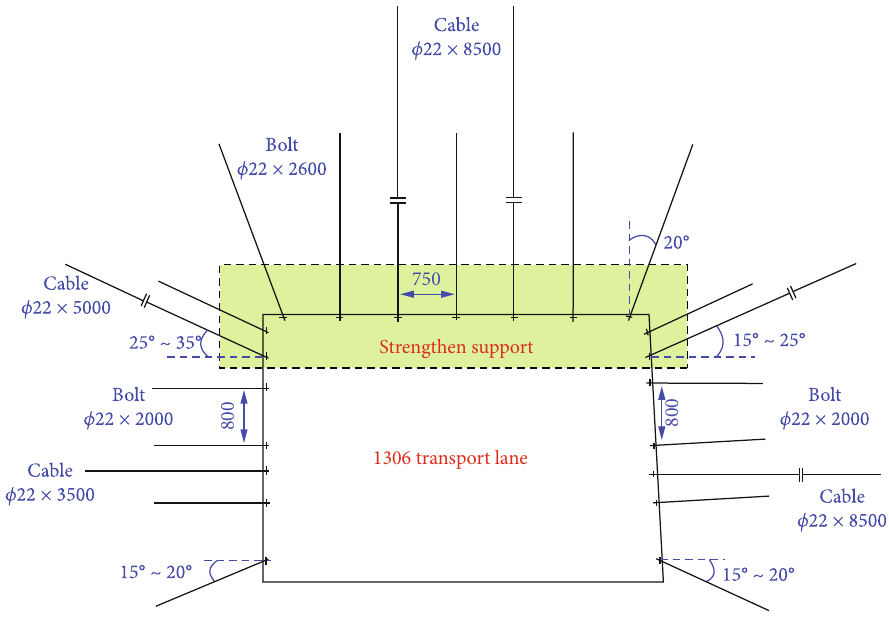
Figure 16: Supporting scheme of the gob-side entry.